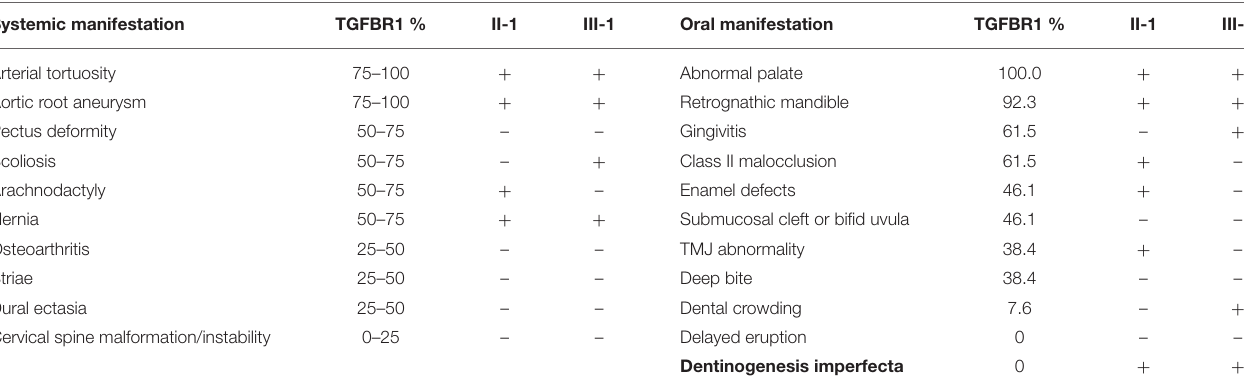
TABLE 1 | Comparison of oral manifestation with previously reported